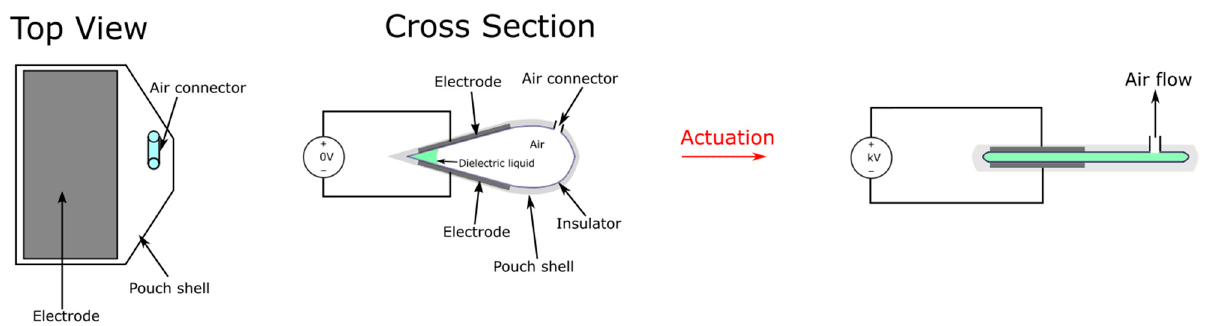
Figure 13. The structure of an electro-pneumatic pump. Illustration inspired by Diteesawat et al. [114]. The electrostatic force generated between the electrodes will be amplified through the dielectric liquid bead, causing a zipping motion of the pouch. During zipping, air will be squeezed out from the air connector.